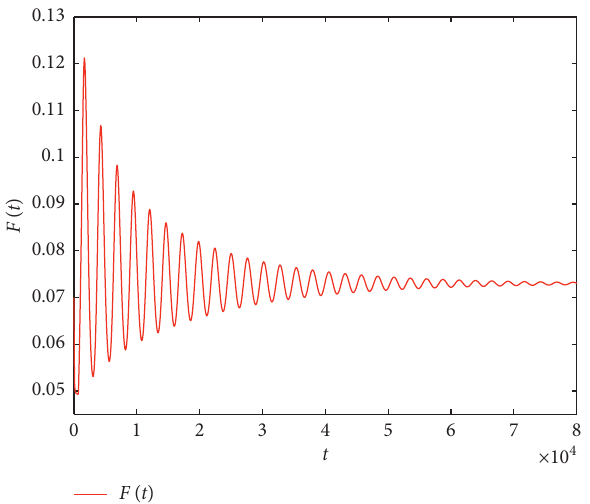
Figure 3: Time series solution of system (30) with ϕ � 0 . 90, � 728 . 403. τ � 700 < τ 0